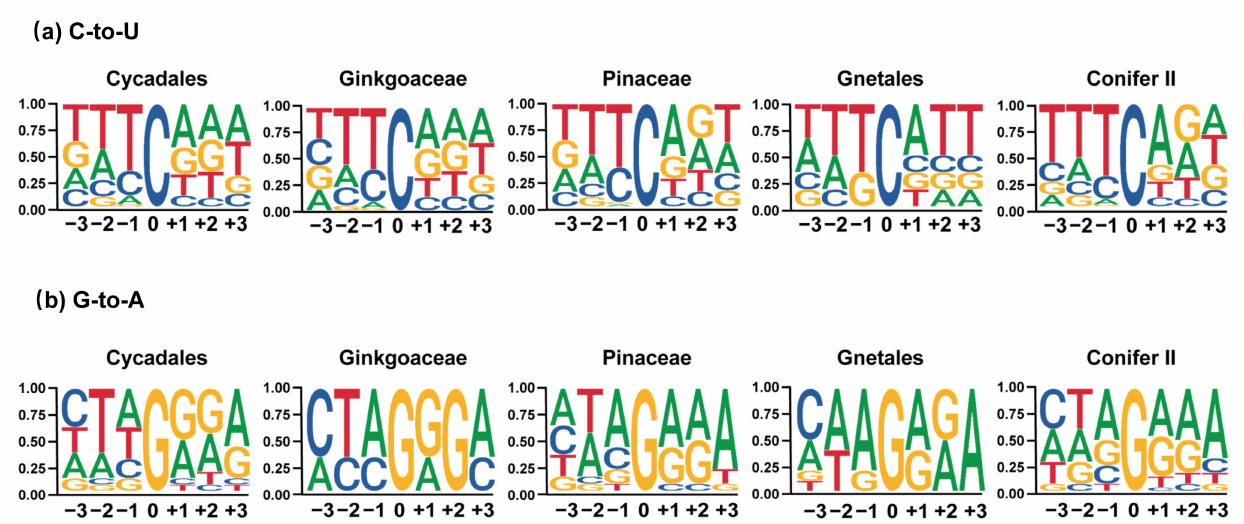
Figure 5. Context (123 sites) flanking the focal C-to-U ( a ) and G-to-A RNA editing sites ( b ) among five gymnosperm lineages. The sequence logos were generated using the “ggseqlogo” package [35].